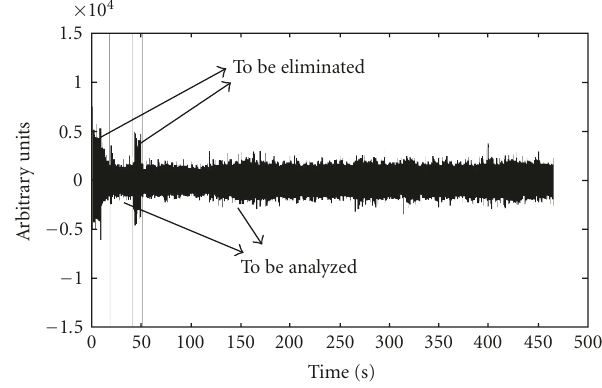
Figure 1: EMG signal and its contents. Contractions have to be de- tected (segmented) and eliminated. x -axis: time in secondS. y -axis: arbitrary